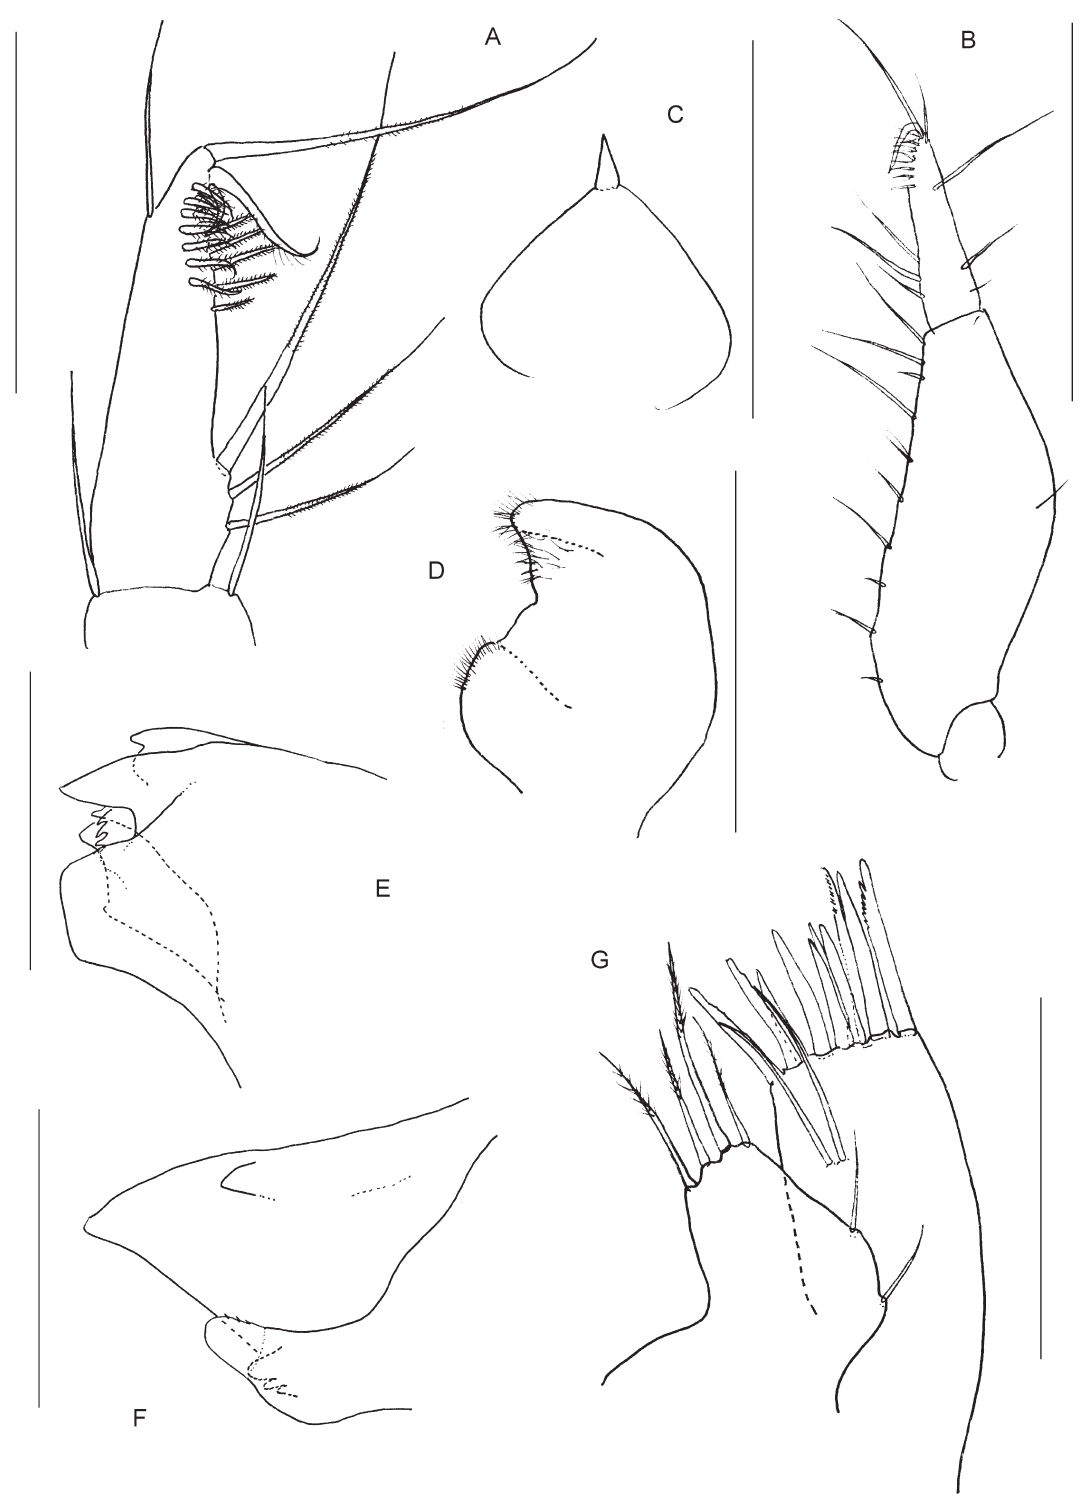
Fig. 4. Siriella bassi sp. nov., holotype, ♀ , length 8.5 mm, Australia, Victoria, Western Bass Strait. A . Distal part of mandibular palp, medial view. B . Mandibular palp, lateral view. C . Labrum, ventral view. D . Labium (left side not shown), posterior view. E . Right mandible. F . Left mandible. G . Maxilla 1, posterior view. Scale bars: A, C–G = 0.1 mm; B = 0.25